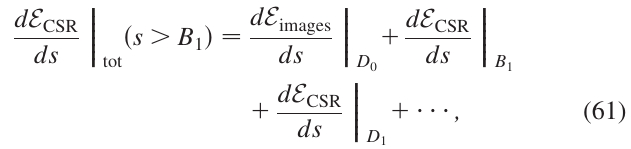
¼ 1 m , while 1 ¼ (cid:7) (cid:1) 1 ¼ 1 2